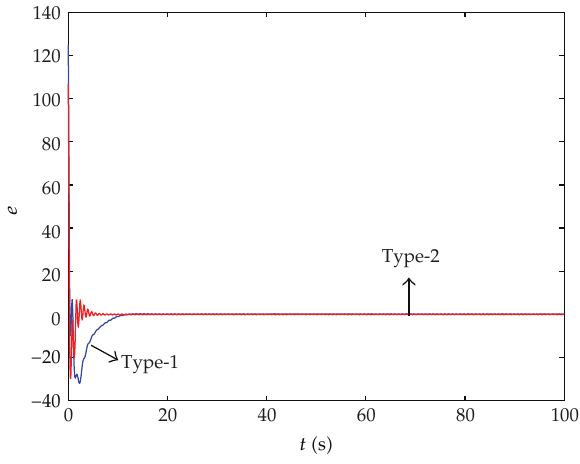
Figure 5: Trajectories of tracking error.